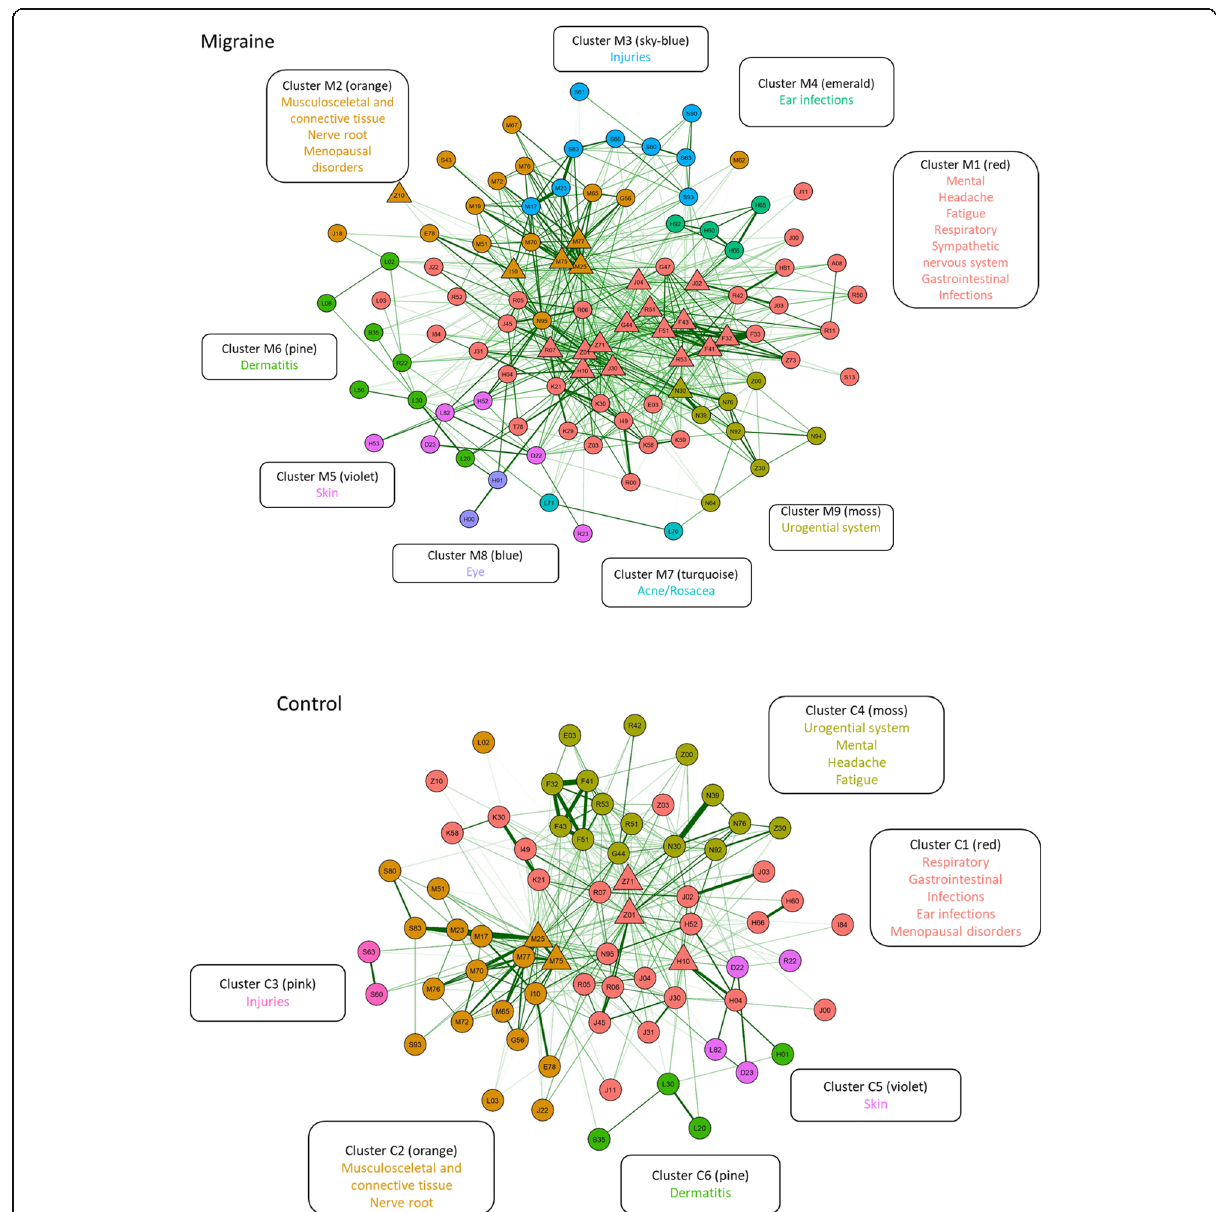
Fig. 2 Comorbidity networks in patients with migraine (upper panel) and age and gender matched controls (lower panel). The visualizations utilize the spring layout where diagnoses with higher phi-correlation are placed closer to each other. Note that only phi-correlations above 0.04 have been visualized to avoid cluttering, however, all statistically significant phi-correlations have been utilized in placing the